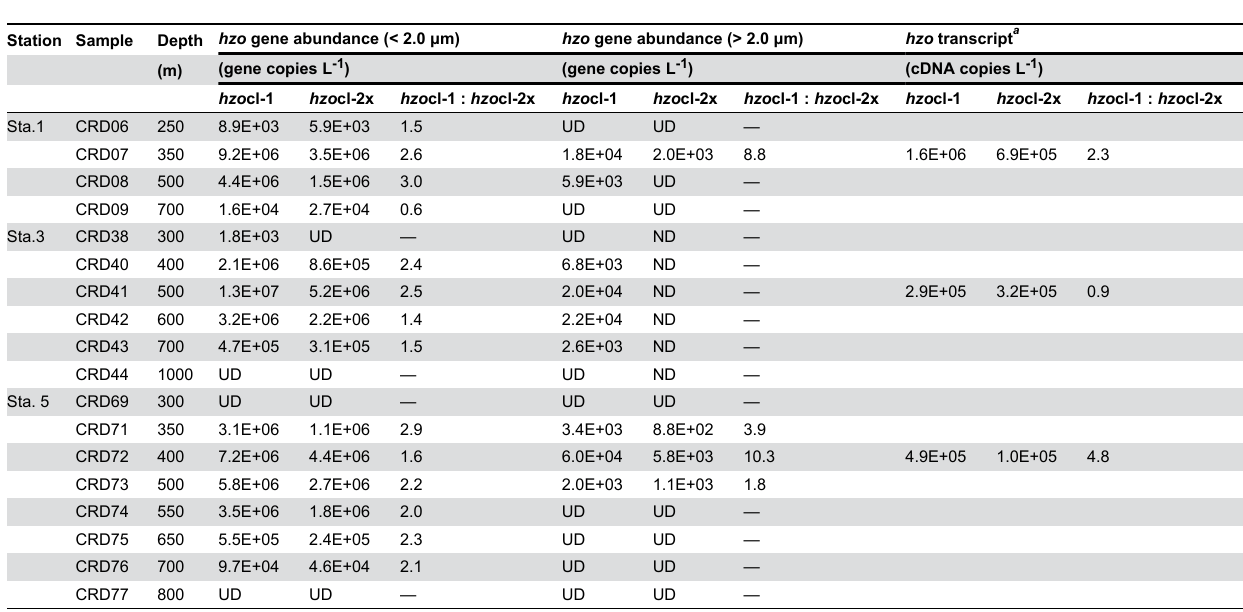
a qRT-PCR analysis was conducted on hzo transcripts of free-living anammox bacteria fraction (< 2.0 μm) only at the depth where hzo gene peak was detected at each station. UD, under the detection limit; ND, not